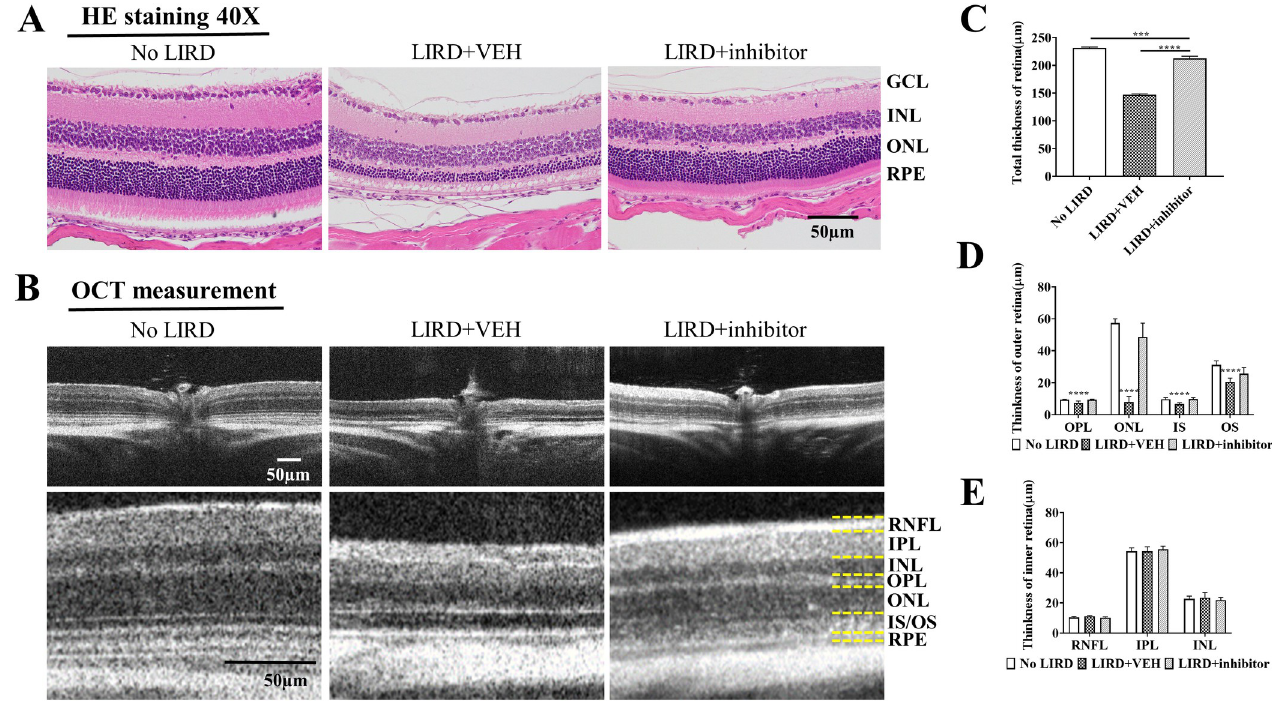
Fig 5. Effect of ( ± )-RPE65-61 on protection against retinal degeneration. LIRD caused the degeneration in the retina and RPE, which was rescued by inhibitor at the dose of 2 mg/kg in BALB/c mice. (A) Representative histological analysis for the retinas of ( ± )- RPE65-61 injected mice 5 days post-LIRD. Retinal cross-sections from three groups were stained with H&E for morphological comparison, 40 × magnification. Scale bar, 50 μ m. (B) Representative OCT images of mice treated with RPE65-61. (C-E) Quantification of the protective effects of ( ± )-RPE65-61 from OCT measurements are shown by measuring the average total thickness of retina (C), outer retina (D) and inner retina (E). RPE: retinal pigment epithelium; IS: outer segment; OS: outer segment; ONL: outer nuclear layer; OPN: outer plexiform layer; INL: inner nuclear layer; IPN: inner plexiform layer; RNFL: The retinal nerve fiber layer. The three groups: No LIRD control, LIRD + Vehicle or LIRD + ( ± )- RPE65-61 . Data expressed as mean ± SEM. n = 8 per group. Student’s t-test. � P < 0.05, �� < 0.01 and ��� < 0.001, ���� < 0.0001.